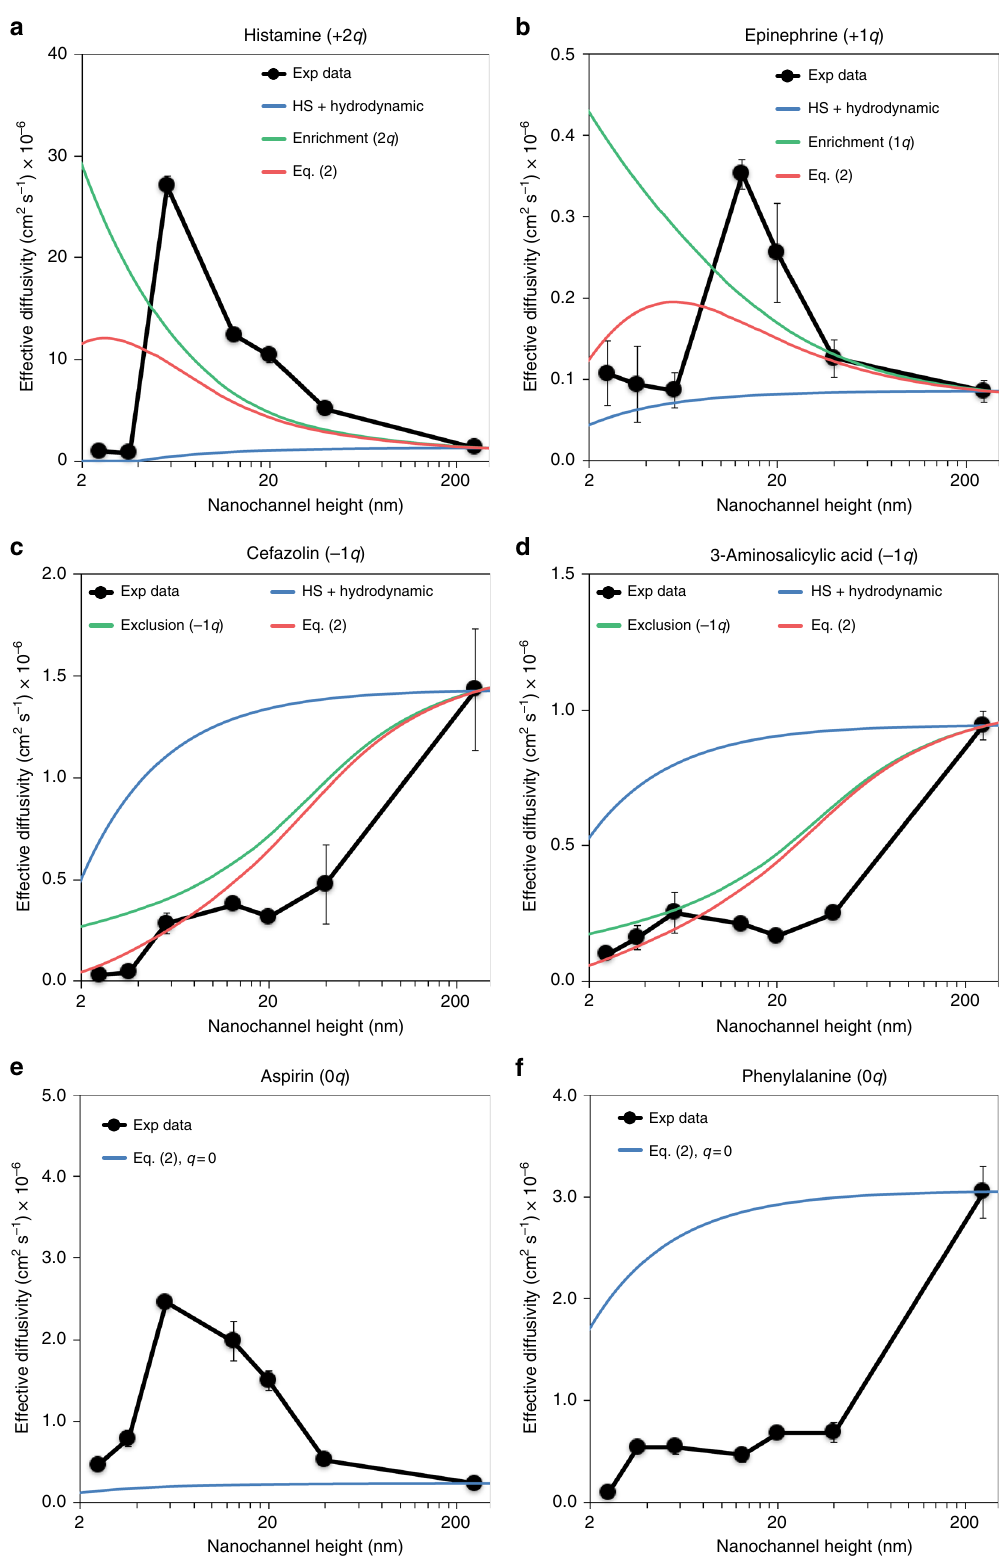
Fig. 3 Effective diffusivity calculated for each analyte and corresponding theoretical prediction based on Eq. (2). Effective diffusivity for positive ( a , b ), negative ( c , d ), and neutral ( e , f ) molecules. The experimental data (black solid circles) are compared in a – d with Eq. (2) including only hard-sphere (HS) and hydrodynamics effects (blue solid lines), only exclusion or enrichment effects (green solid lines), and the full Eq. (2) (red solid line). The green line is computed from Eq. (2) with r s = 0 and K = 1, corresponding to neglecting HS and hydrodynamic interactions. e , f show diffusivity data for two neutral species. As in the previous panels, blue solid lines are computed from Eq. (2) with q = 0. Each of the data points denotes the average of three individual replicates, error bars are